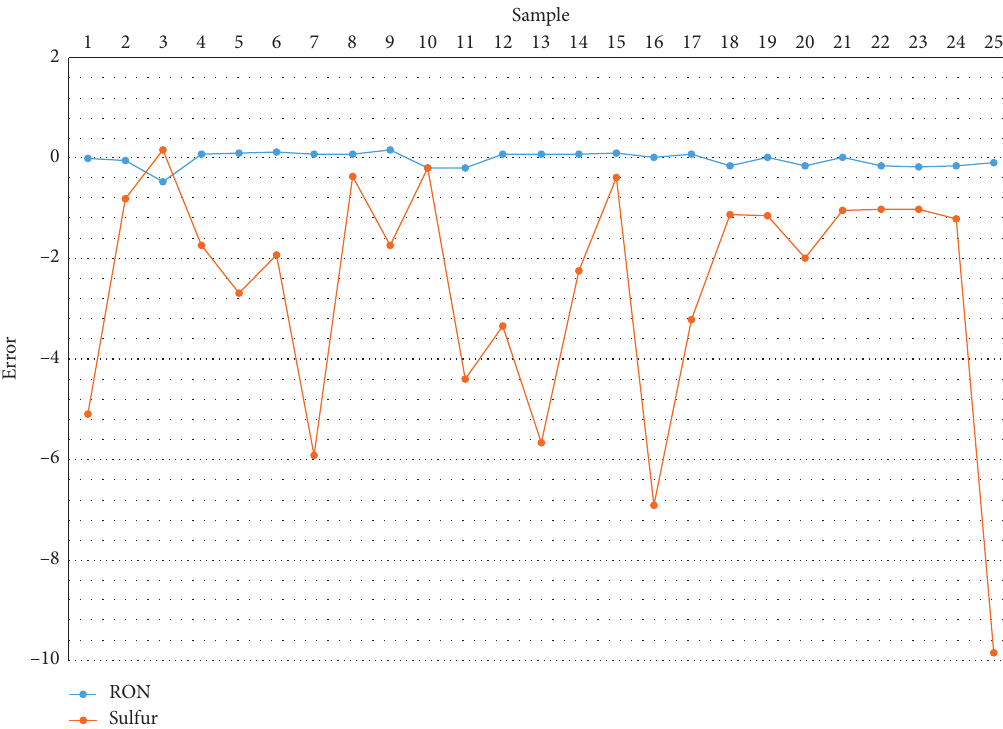
Figure 5: Error between the predicted value and the true value.